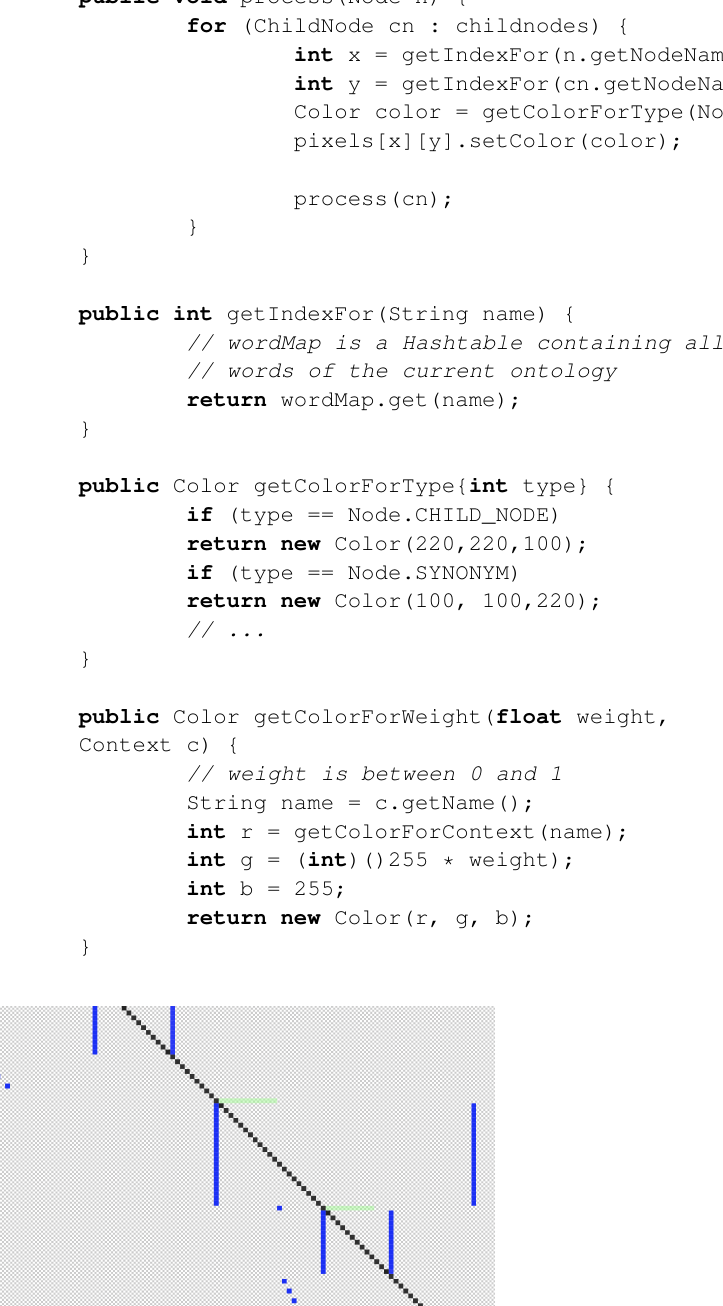
Figure 13. Snippet of generated graph code from the original input